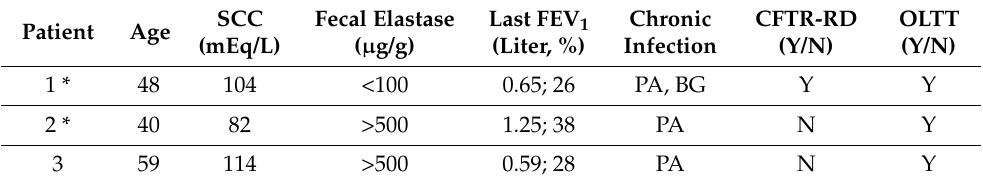
Table 1. Summarizes the main clinical parameters of the three patients in our